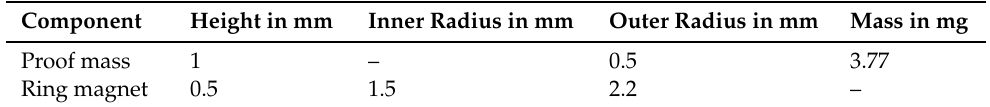
Table 1. Magnet dimensions used in this study.